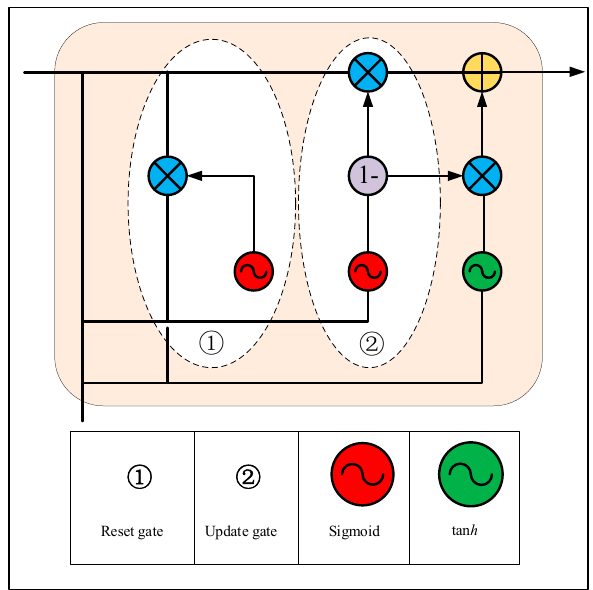
Figure 16. GRU unit structure.